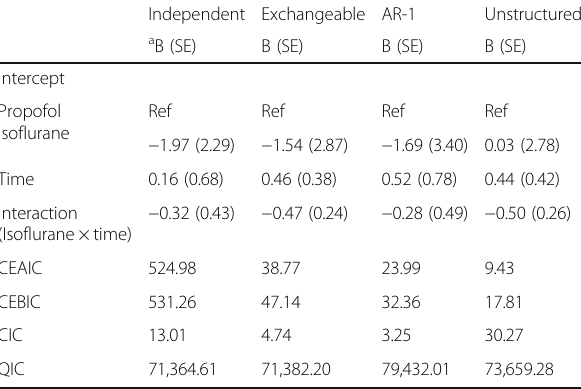
Table 5 Results of fitting GEE model, EAIC, and EBIC criteria for MAP